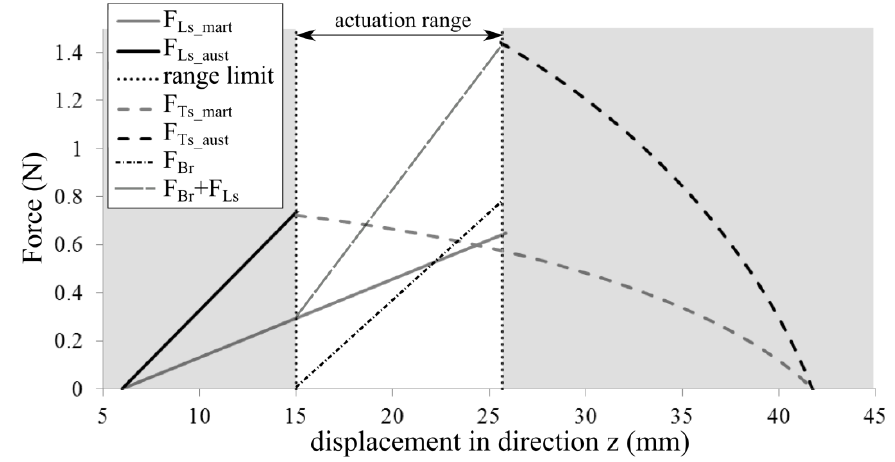
Figure 3. Equilibrium of the forces in the direction of axis z (Figure 2). Black and grey solid lines: austenitic and martensitic force of longitudinal springs, respectively. Black and grey dashed lines: austenitic and martensitic force of transverse springs respectively. Dots and dashed line: force of the braided sleeve. Long dashed line: sum of the force of the braided sleeve and the longitudinal spring force in martensitic